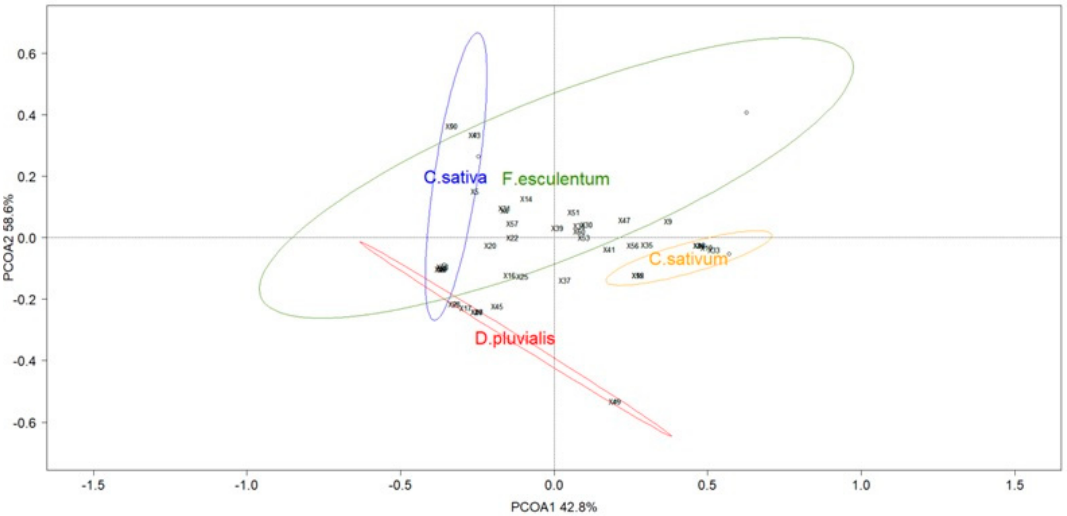
Figure 5. Principal coordinate analysis (PCoA) ordination of the four flower species with data collected with a net (red circle: D. pluvialis ; yellow circle: C. sativum ; green circle: F. esculentum ; blue circle: C. sativa ). Ellipses show the 80% confidence interval of the locations grouped by flower species. Species scores are represented with numbers (Table S2).